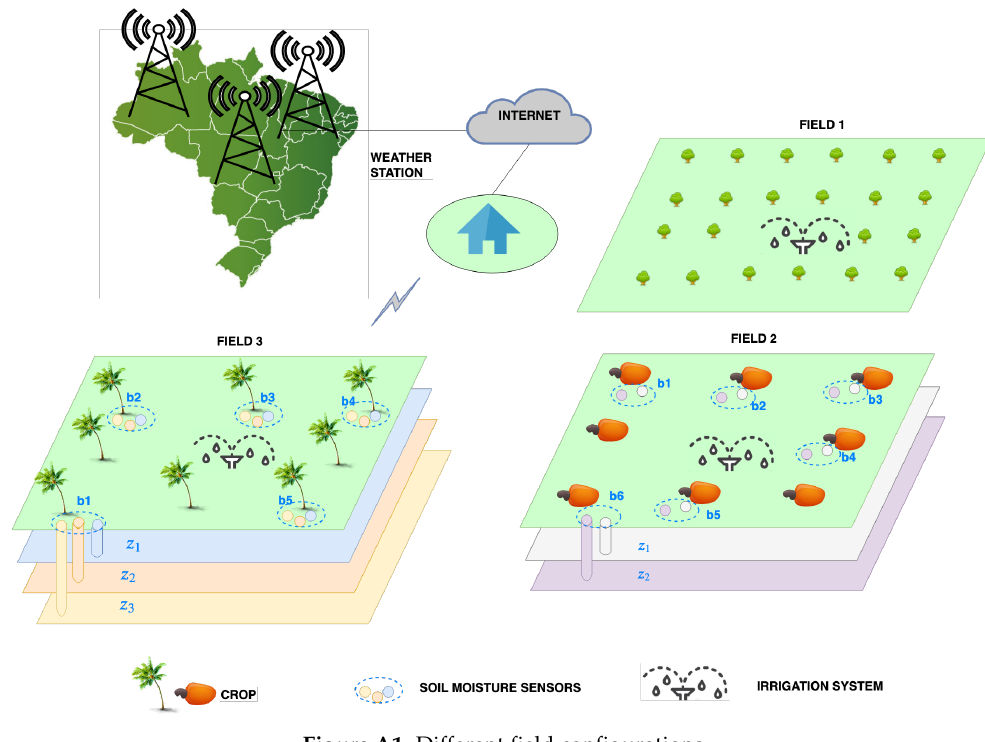
Figure A1. Different field